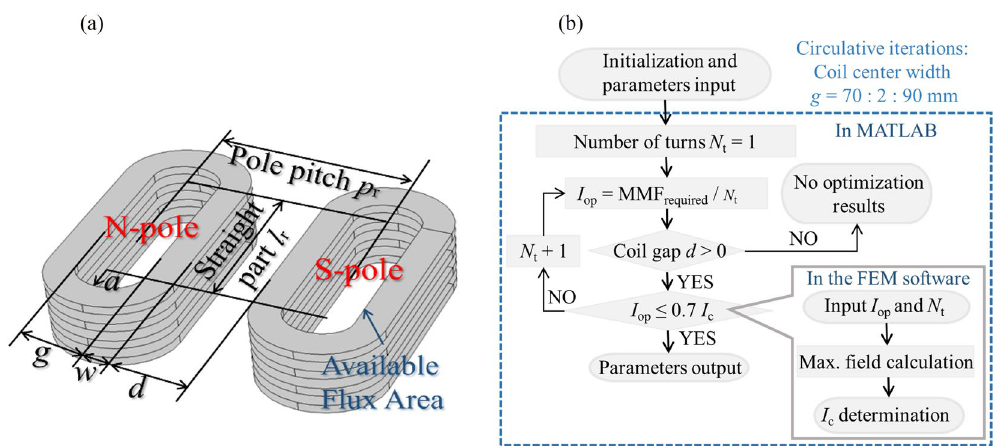
Figure 2. Design optimization of the HTS magnets, including ( a ) design constraints and ( b ) optimization process. The optimization process preferentially control N t since the increasement of it means more HTS wires consumed. The optimization occurs when I op = 0.7 I c . The design optimization is implemented through MATLAB combining with